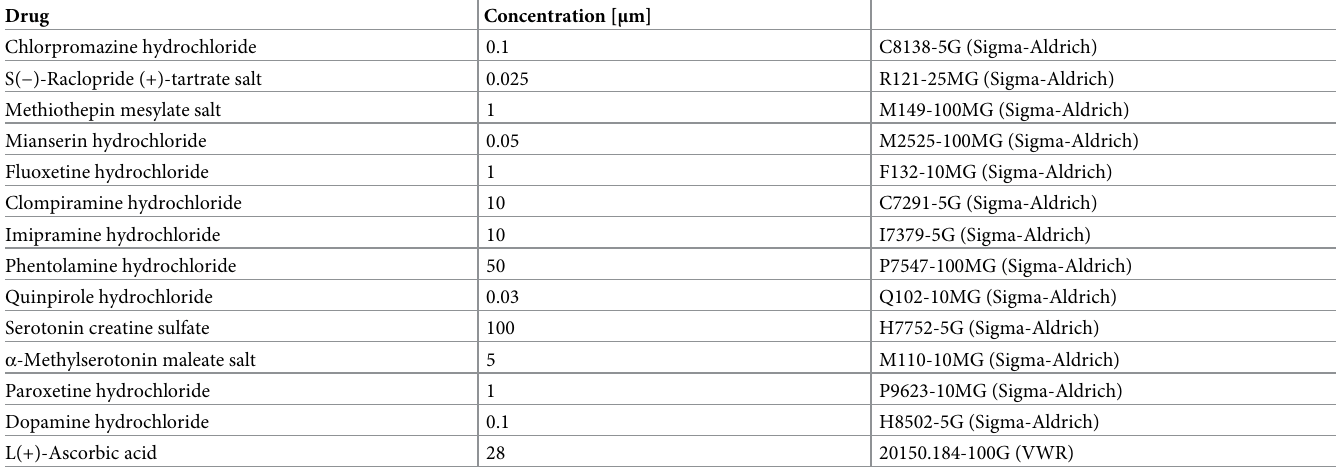
Table 1. Working concentrations of drugs used in this